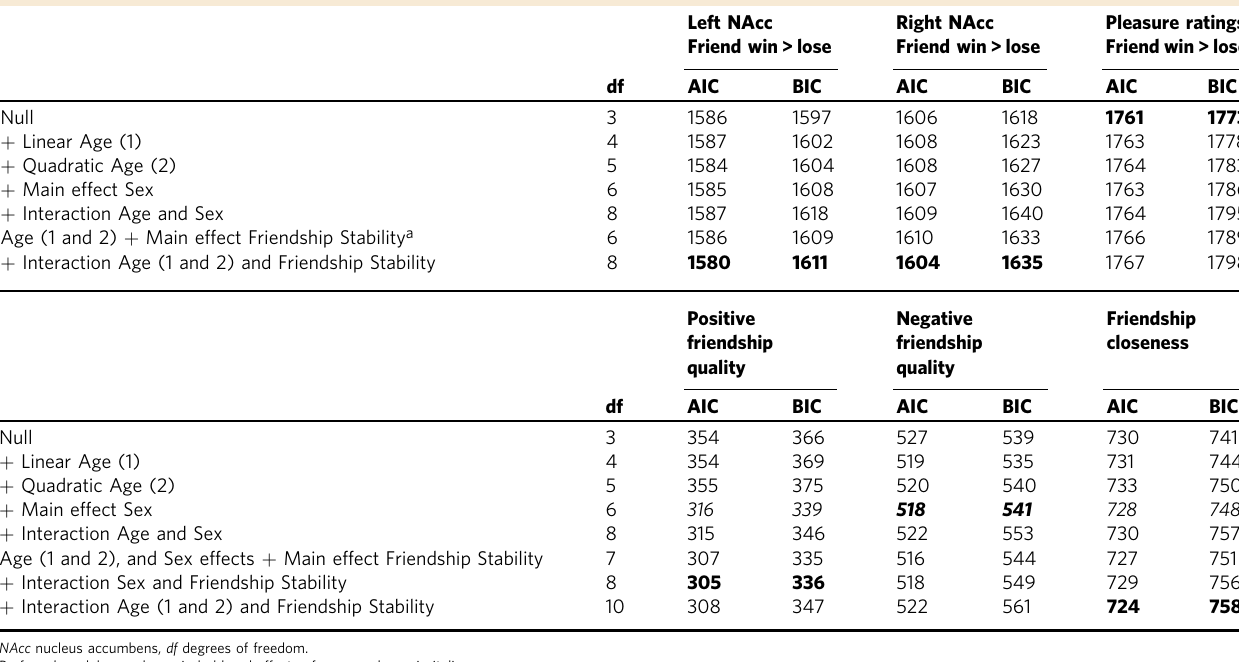
Table 1 AIC and BIC values for the models to describe the relation with age, sex, and friendship stability.